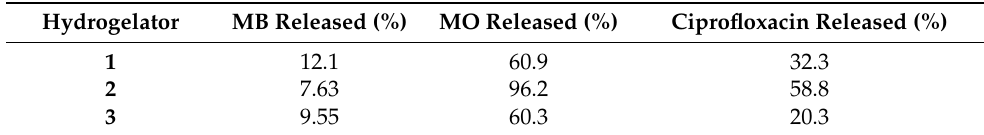
Figure 9. Representative images of hydrogels layered with water after a saturating release study (6 days). ( A ) Hydrogels of 1 loaded with methylene blue (left), methyl orange (center), and ciprofloxacin (right), that were layered with 1.5 mL of H 2 O. ( B ) Inverted vials from panel ( A ). ( C ) Hydrogels of 2 loaded with methylene blue (left), methyl orange (center), and ciprofloxacin (right), which were layered with 1.5 mL of H 2 O. ( D ) Inverted vials from panel ( C ). ( E ) Hydrogels of 3 loaded with methylene blue (left), methyl orange (center), and ciprofloxacin (right), which were layered with 1.5 mL of H 2 O. ( F ) Inverted vials from panel ( E ). Table 4. Percentage release of cargo from hydrogels 1 – 3 after 6 days. Hydrogelator